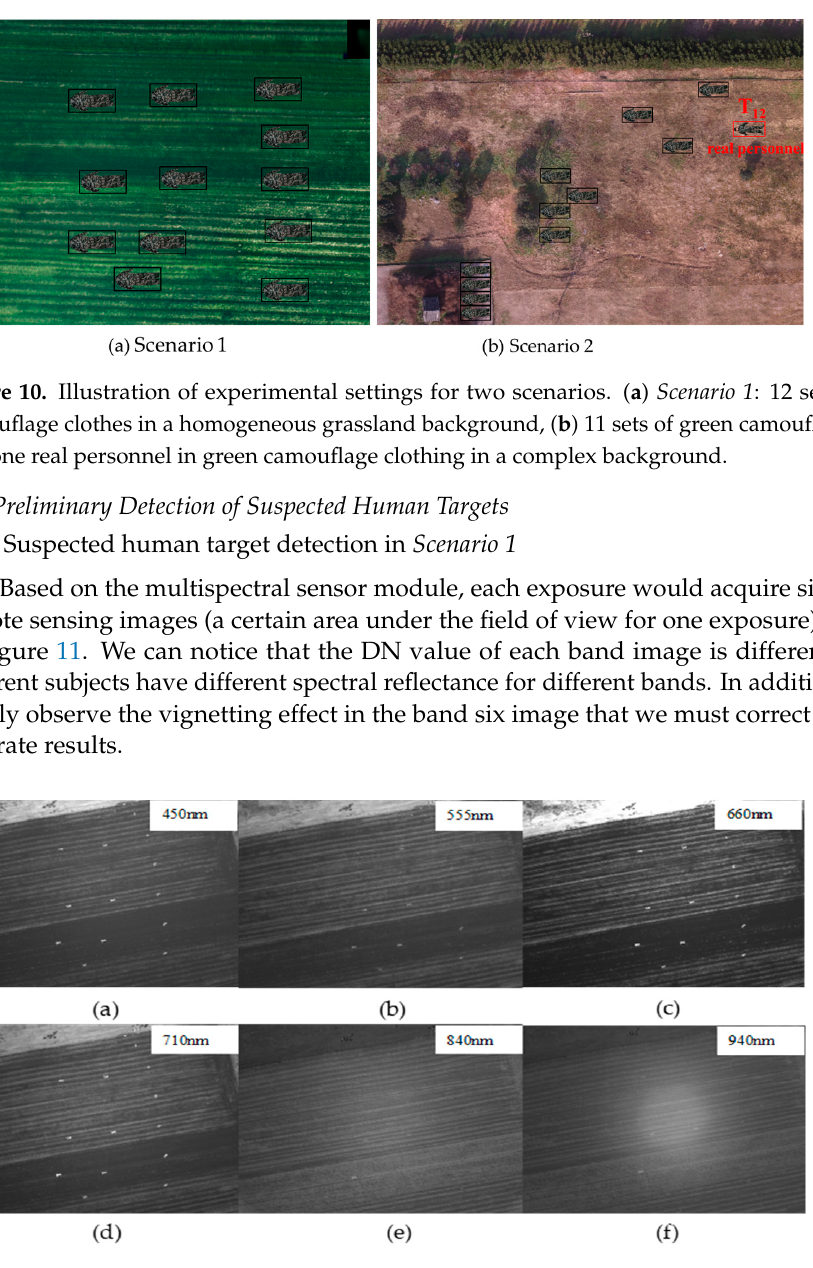
Figure 11. Local multispectral remote sensing images in Scenario 1 acquired by MS600 (one exposure): ( a ) 450 nm; ( b ) 555 nm; ( c ) 660 nm; ( d ) 710 nm; ( e ) 840 nm; ( f ) 940 nm.